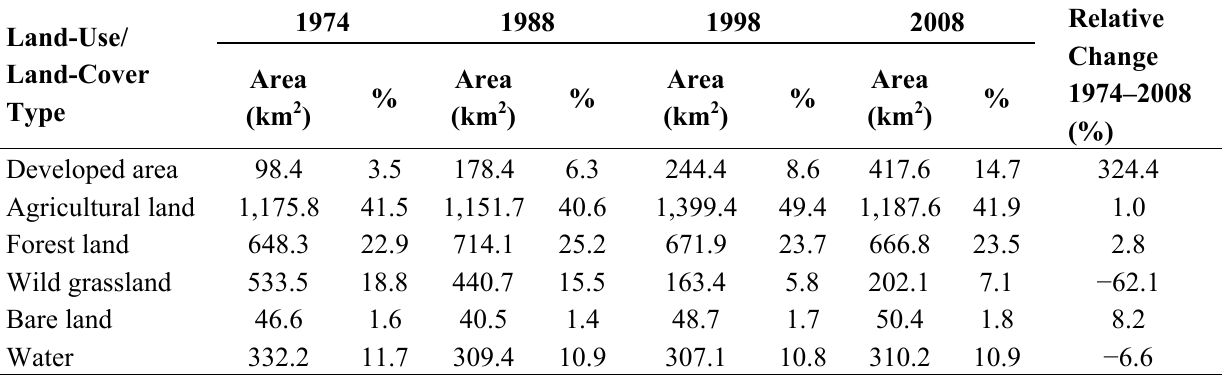
Table 3. Structure and changes in land-use/land-cover: 1974, 1988, 1998, and